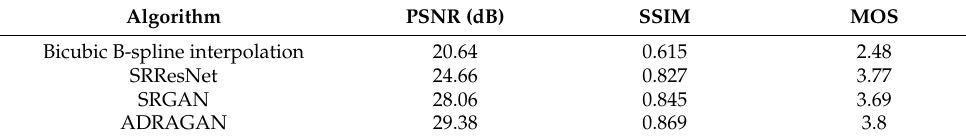
Table 5. Comparison of mean evaluation index results for four algorithms on the test